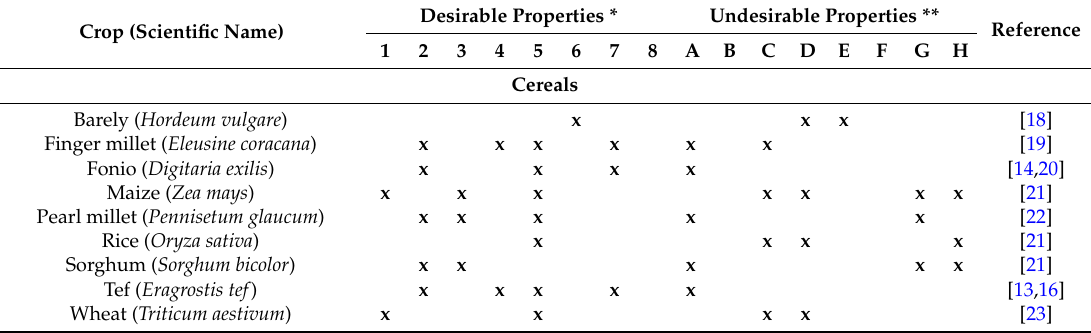
Table 1. Desirable and undesirable properties of selected crops cultivated in